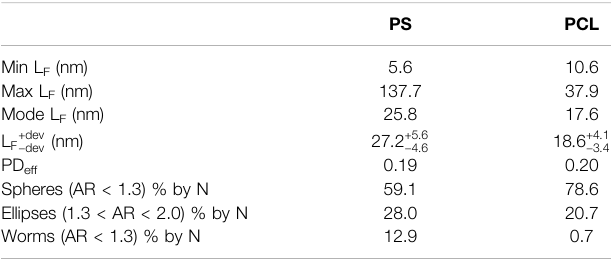
TABLE 4 | Size characteristics of Coumarin 6 loaded PS- b -PEO and PCL- b -PEO NPs synthesized at the breakpoint at which drug EE no longer increases with increasing polymer:drug